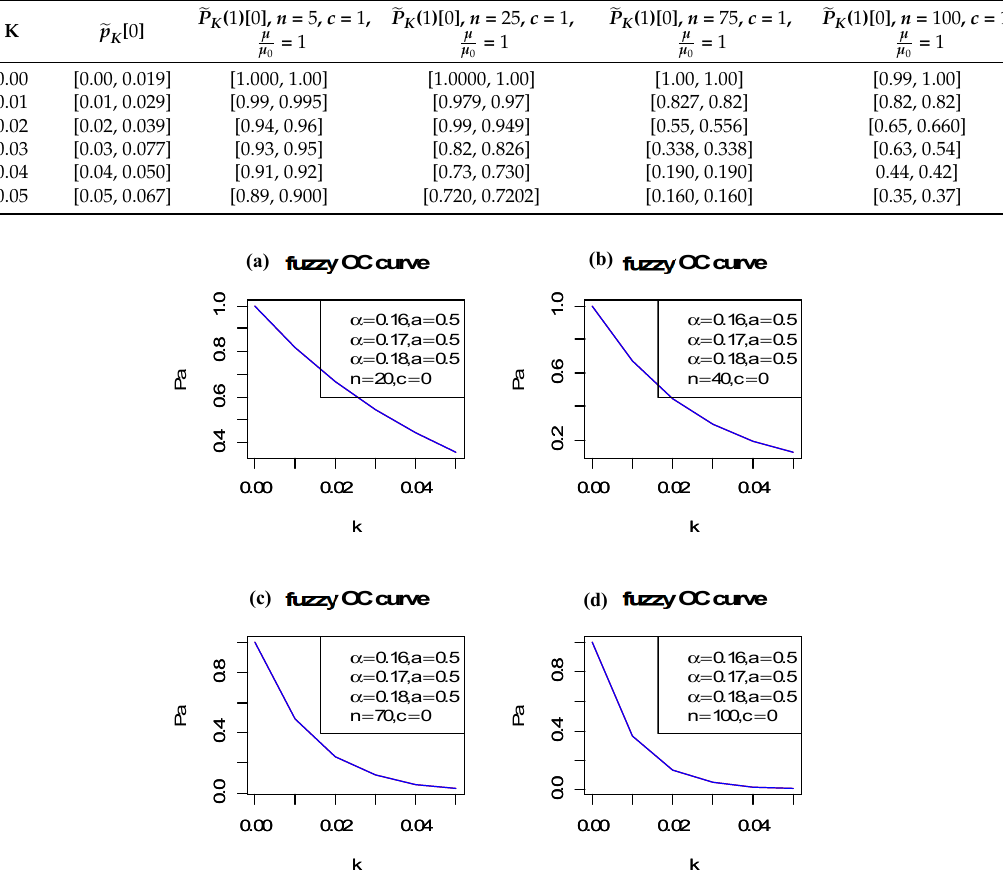
Figure 1. The fuzzy operating characteristic (OC) Curve of the Birnbaum-Saunders distribution at c = 0 ( a ) n =20, ( b ) n = 40, ( c ) n = 70, and ( d ) n = 100.